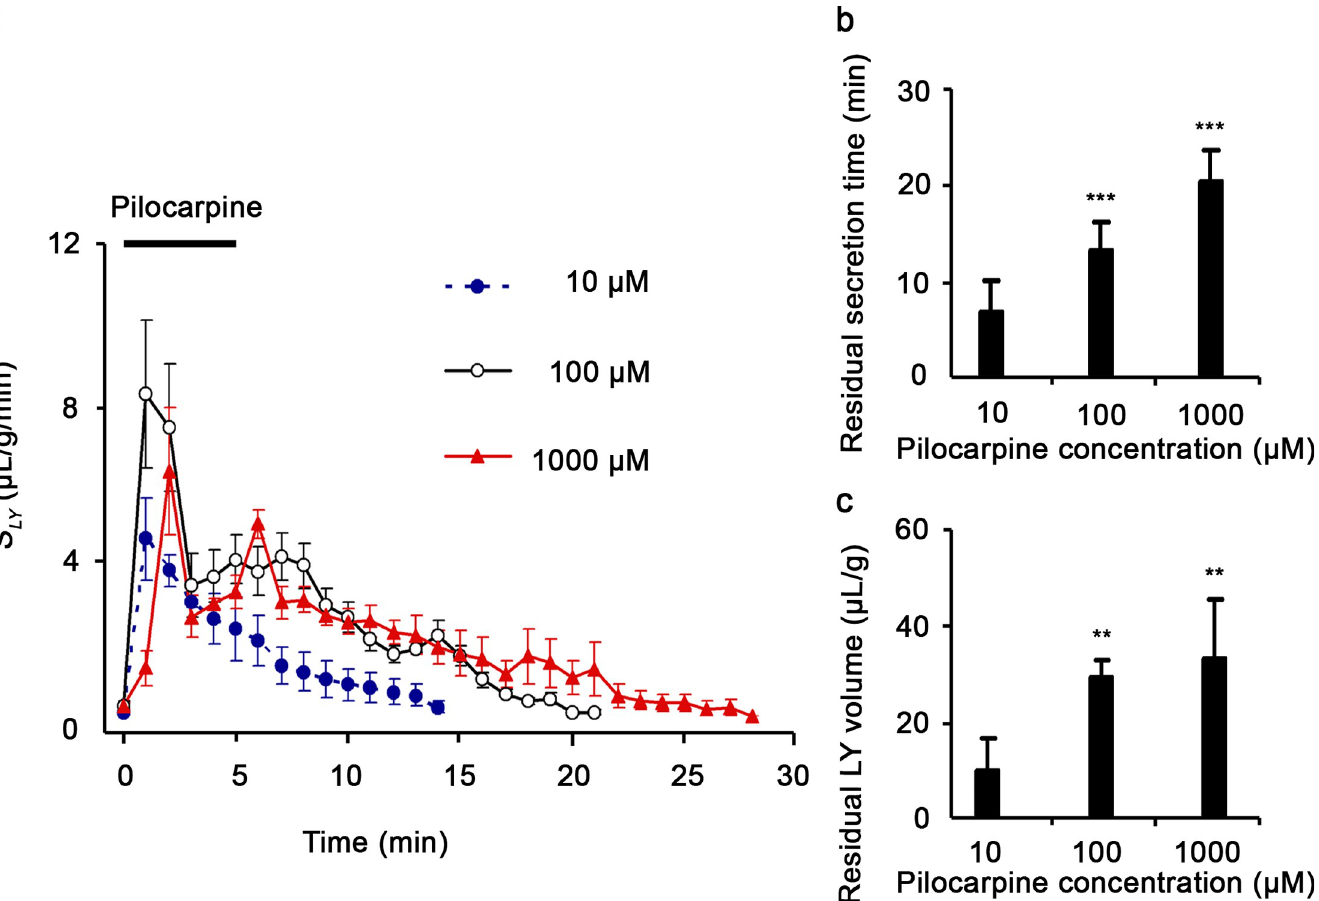
Fig 4. Residual paracellular secretion induced by pilocarpine in perfused submandibular glands of rats. Profile of pilocarpine-induced Lucifer Yellow (LY) secretion in perfused submandibular glands of rats (a). Submandibular glands were stimulated with 10–1000 μ M pilocarpine for 5 min, and LY in secreted saliva was determined. Stimulation time is depicted as a black bar. Results are representative of three independent experiments. Dose-dependent effect on time (b) and volume (c) of pilocarpine-induced LY secretion. Data are means ± S.E. of three independent experiments. �� , P < 0.01 and ��� , P < 0.001 compared with unstimulated glands.